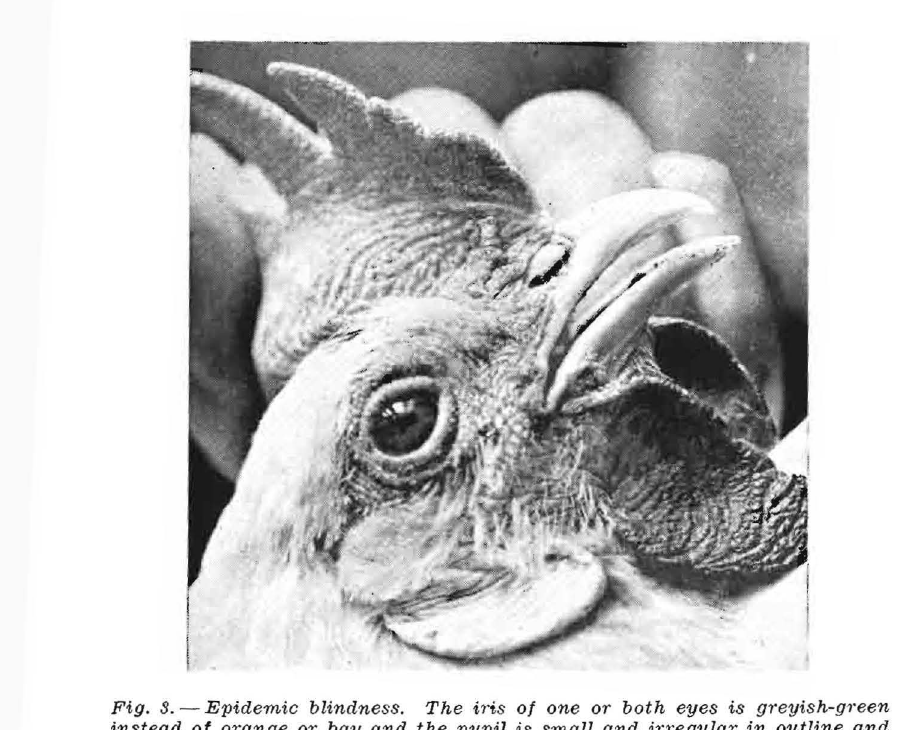
Fig. S. - Epidemic blindness. The il'is of one or both eyes is gl'eyish-g?'een instead of orange or bay and the pupil is small and ilTegular in outline and does not l'espond to changes in light. Such a bird would not be used for bTeeding pUTposes, and its brothel's and sisteTs should also be discaTded if not excellent in all otheT Tespects. It must be v-iewed almost as seTiously as neurolymphomatosis.